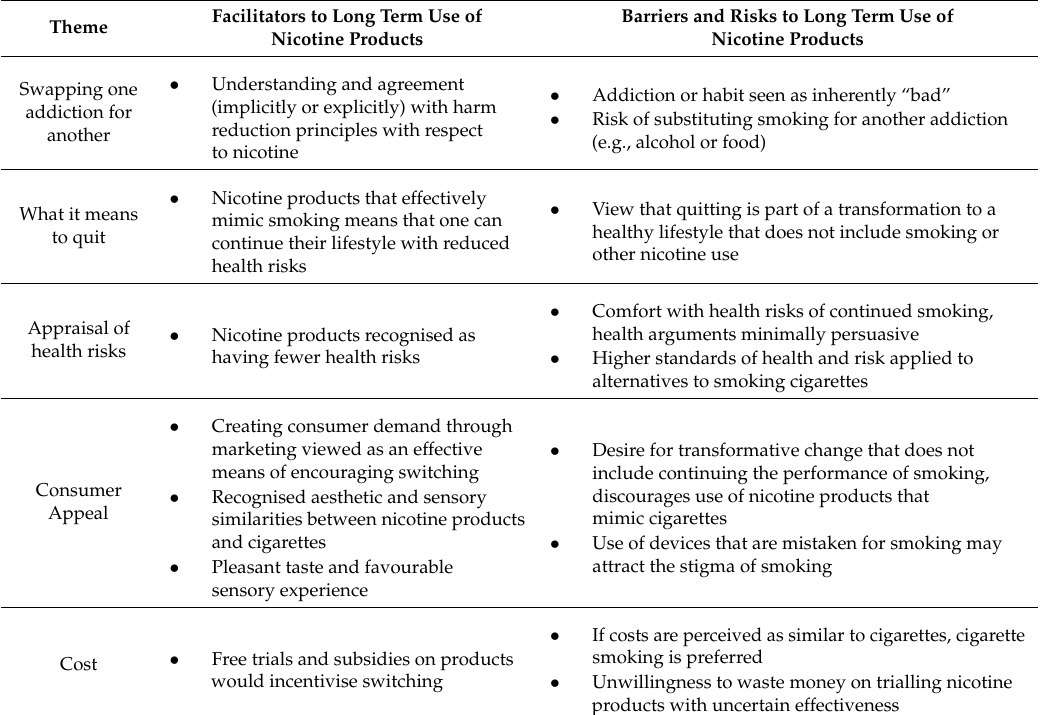
Table 3. Consumer reported facilitators and barriers to using Nicotine Products as a long term substitute for